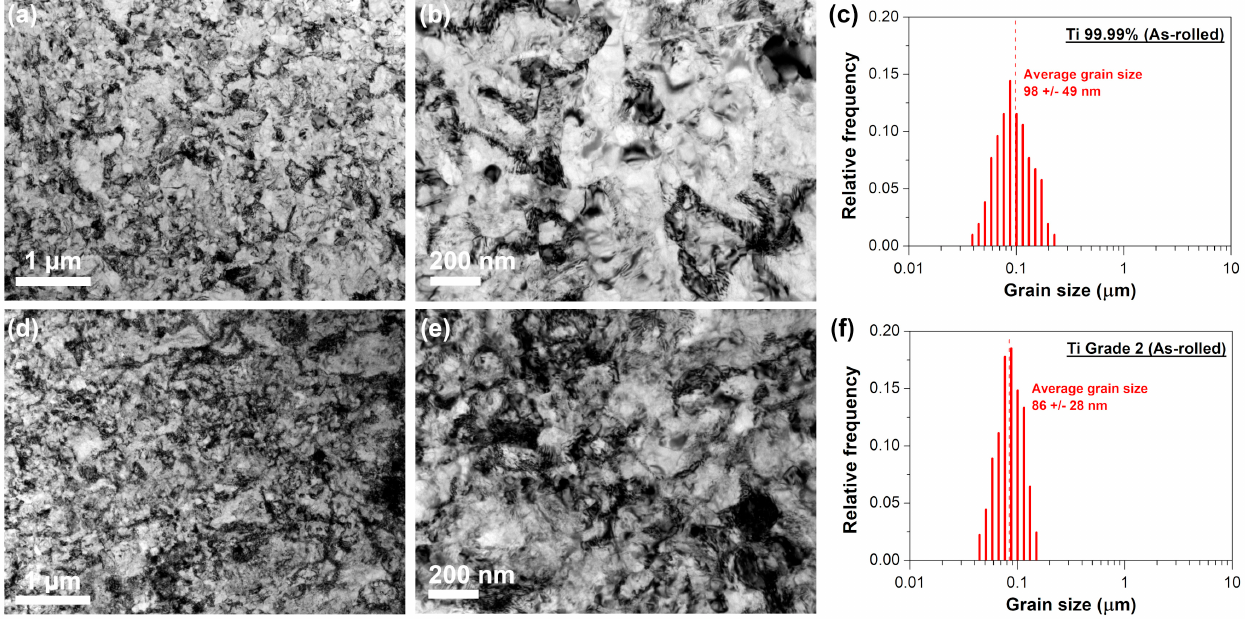
Figure 1. Microstructure of the as-rolled sheets: ( a , b ) Ti 99.99% and ( d , e ) Ti Grade 2 with the corresponding grain size distributions ( c , f ).